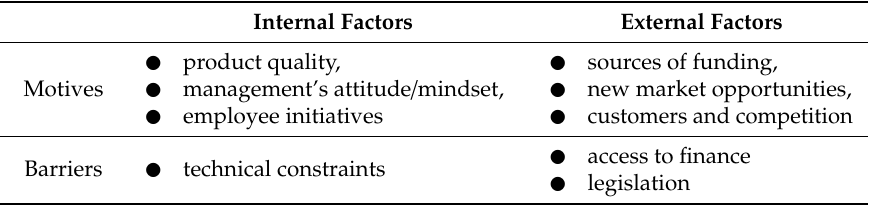
Table 2. Motives and barriers to innovation in enterprises form the bioeconomy